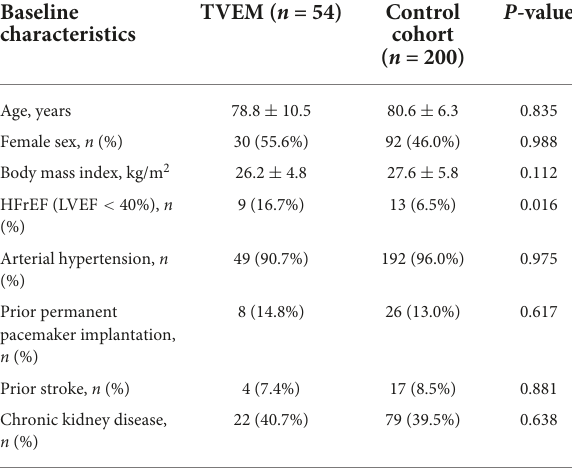
TABLE 2 Baseline characteristics of all transcatheter valve embolization and migration (TVEM) patients and the control cohort.